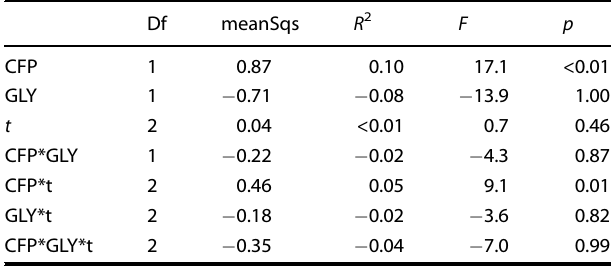
Table 1. Adonis test for in fl uence of concentrate feed proportion, glyphosate, and time on weighted UniFrac distances between microbial